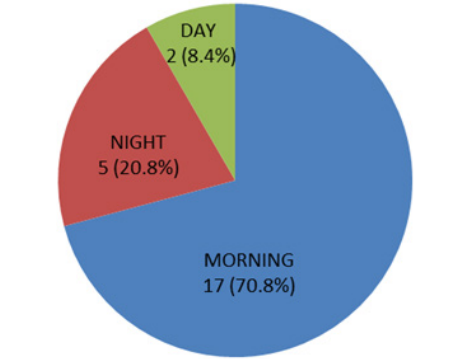
Figure 1: Age Distribution of Patients with Periocular Paederus Dermatitis.